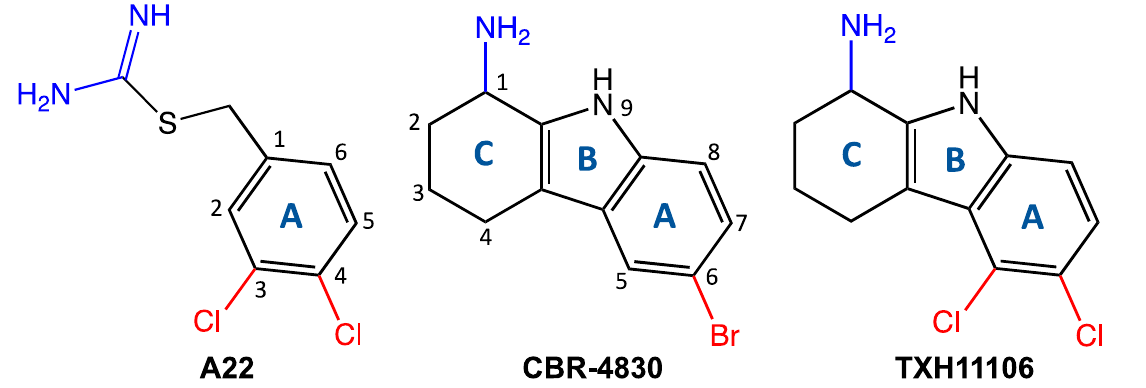
Figure 1. Chemical structures A22, CBR-4830, and TXH11106, with the lettering and atomic numbering of the rings being as indicated. The basic functionalities of each compound are highlighted in blue and the halogen substituents on ring A of each compound are highlighted in red.